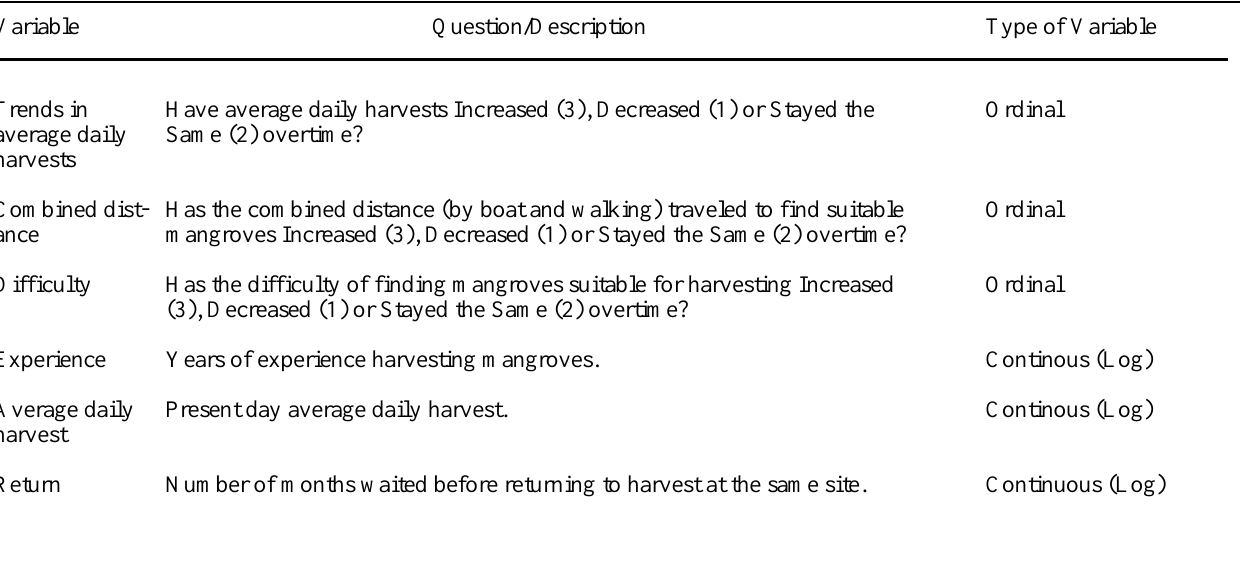
Table 1. Descriptions of the six questionnaire variables used in the principle components analysis (PCA) ordination. The type of variable, and whether the variable was log-transformed is noted. Variable Question/Description Type of Variable Trends in average